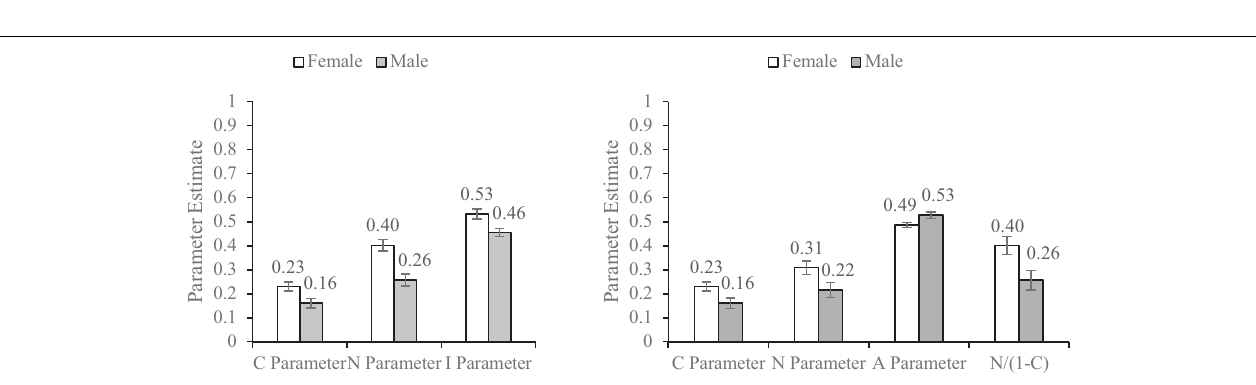
FIGURE 3 | Results of Study 1a by Gawronski et al. (2017) obtained from the CNI model (left) and CAN algorithm (right) . Error bars represent ± 1 SE.